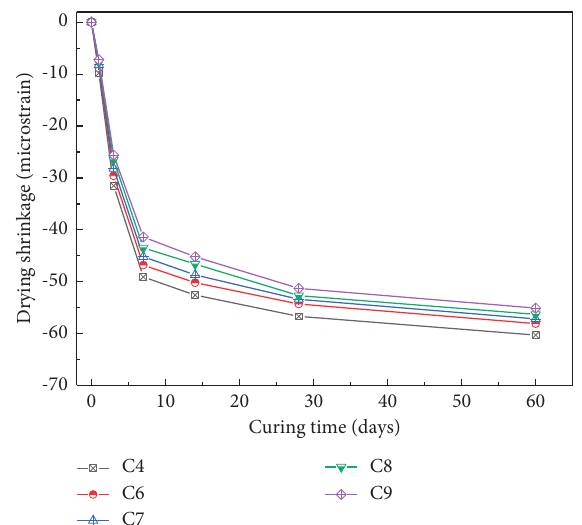
Figure 9: The drying shrinkage of the hardened sample with different additions of